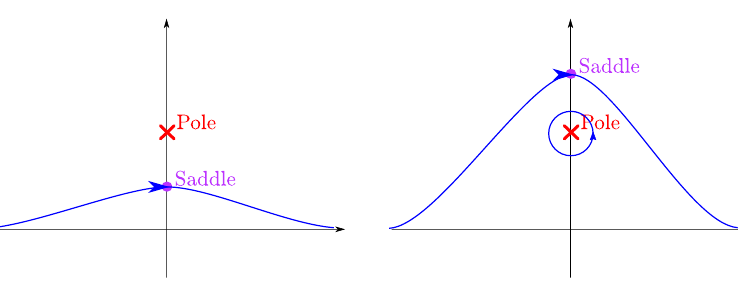
Figure 5 . The generic mechanism for saturating the bounds (1.7){(1.8) above some critical velocity. The growing contribution to the OTOC is given by an integral, that can be evaluated by saddle point for large t . The integration contour is drawn by a blue solid line. As we increase the velocity v , the saddle point shifts in the direction of the imaginary axis, and eventually it crosses a pole. After this, the contribution of the pole dominates the